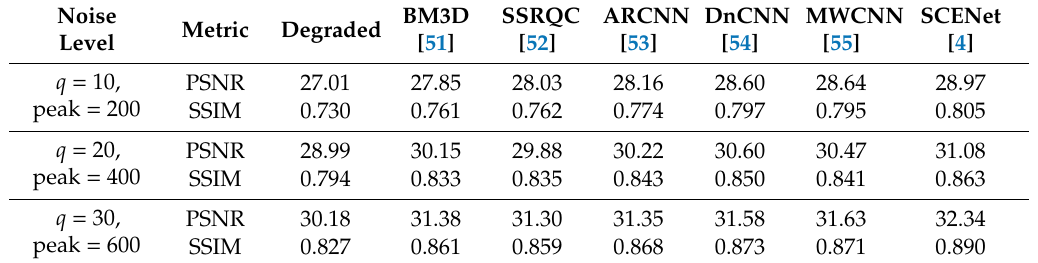
Table 2. Comparison of the quantitative denoising quality of the LIVE1 database in terms of average PSNR (dB) and